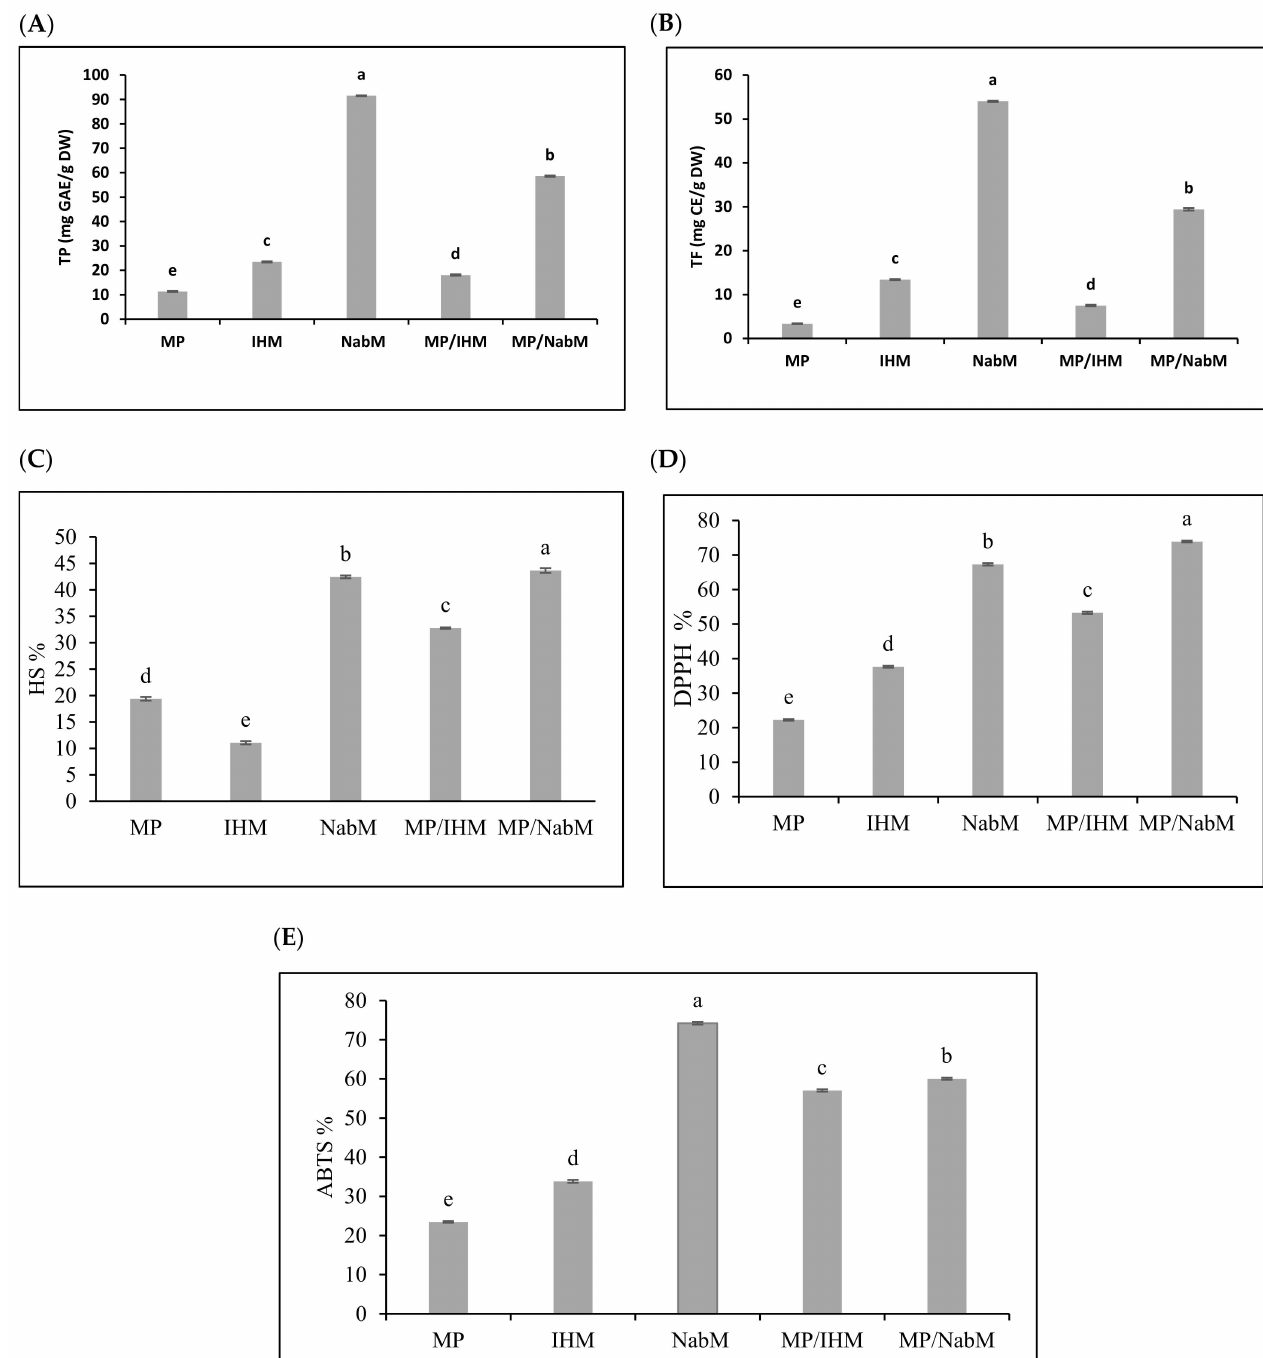
Figure 3. Total phenolic and total flavonoid content ( A , B ) and antioxidant activity ( C – E ) of MP, IHM, NabM, and MPMC. MP: milk proteins concentrate; IHM: Isabgol husk mucilage; NabM: Nabeq mucilage; TPC: total phenolic content; GAE: gallic acid equivalent; TF: total flavonoid; CE: catechin equivalent; DW: dry wight; DPPH: 2,2-diphenyl-1-picrylhydrazyl; ABTS: 2,2 (cid:48) -azino-bis (3-ethylbenzothiazoline-6-sulphonic acid; HS: hydroxyl scavenging; Values are means ± SD (n = 3). Measurements with different letters (a, b, c, d, and e) are significantly different ( p <